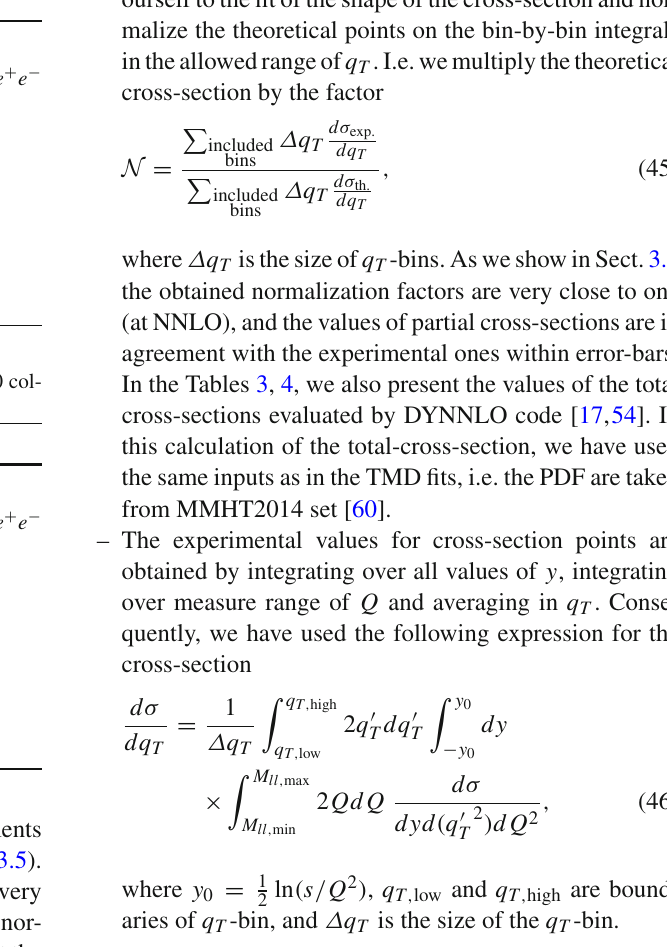
Table 3 The characteristics of the data measured at CDF and D0 col- laborations at run 1 CDF run I D0 run I